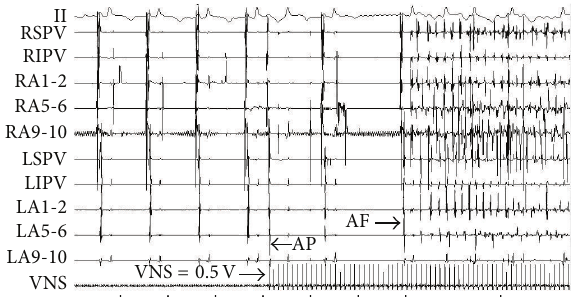
Figure 7: Vagosympathetic nerve stimulation (VNS) promoted atrial arrhythmia. VNS with the voltage at 0.5 V triggered atrial premature and then facilitated AF. AP: atrial premature. AF: atrial